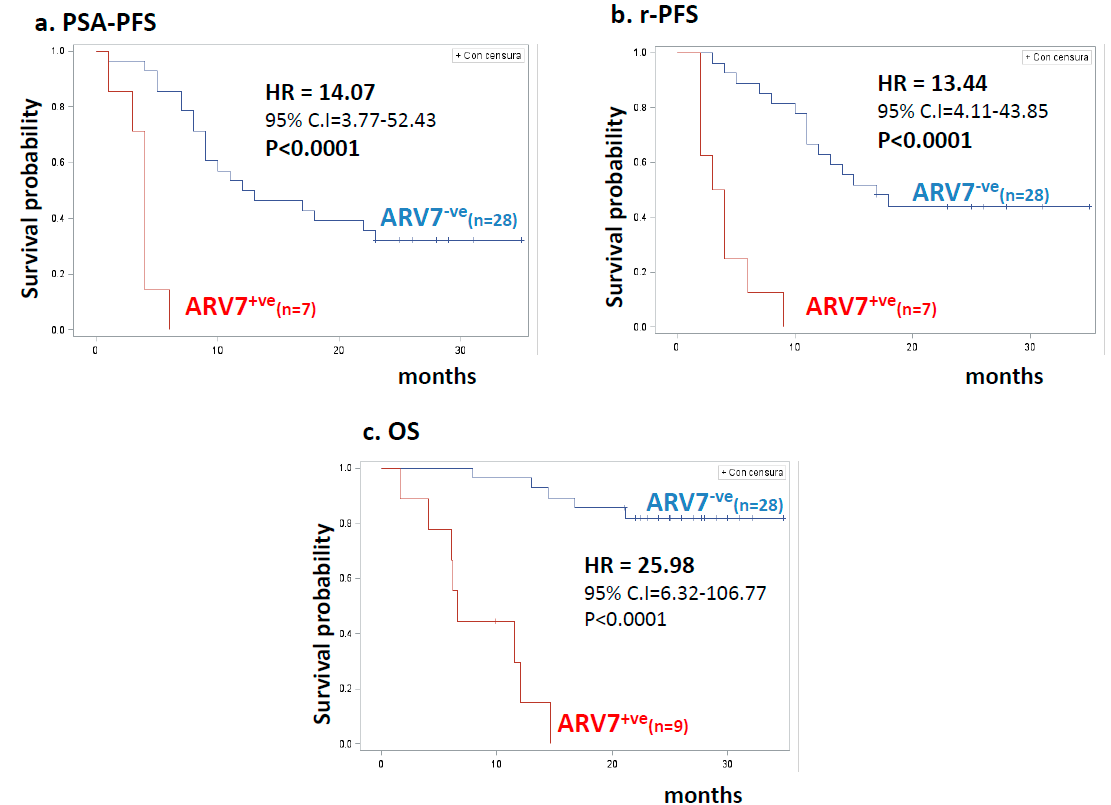
Figure 3. Kaplan–Meier estimates for clinical outcome in patients stratified by ARV7 detection. ( a ) PSA-progression-free survival (PSA-PFS) according to ARV7 detection. Blue and red lines indicate 28 ARV7-negative (ARV7 − ve ) and seven ARV7-positive (ARV7 + ve ) patients, respectively. HR values, 95% confidence interval (CI), number of patients, and statistical significance are reported in the inset. ( b ) Radiologic progression-free survival (rPFS) according to AR status. Blue and red lines indicate 28 ARV7-negative (ARV7 − ve ) and seven ARV7-positive (ARV7 + ve ) patients, respectively. HR values, 95% confidence interval (CI), number of patients, and statistical significance are reported in the inset. ( c ) Overall survival (OS) according to ARV7 status. Blue and red lines indicate 28 ARV7-negative (ARV7 − ve ) and nine ARV7-positive (AR + ve ) patients, respectively. HR values, 95% confidence interval (CI), number of patients, and statistical significance are reported in the inset.